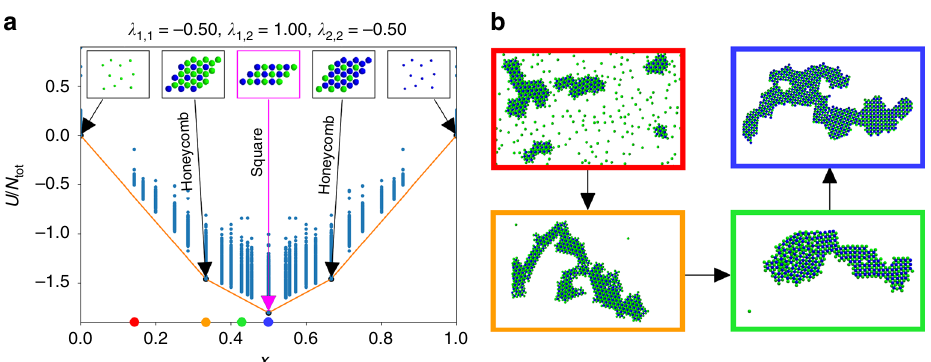
Fig. 4 Constructing phase diagrams for a binary mixture. a Optimized results, as in Fig. 3b, from many stoichiometries can be combined to form a phase diagram. All points above the hull are metastable structures. b Representative snapshots from molecular dynamics simulations at T * ≈ 0.05 for mole fractions of x 1 ∈ [0.17, 0.33, 0.42, 0.50] depicted in red, orange, green, and blue, respectively, demonstrate the validity of the predictions in panel a and